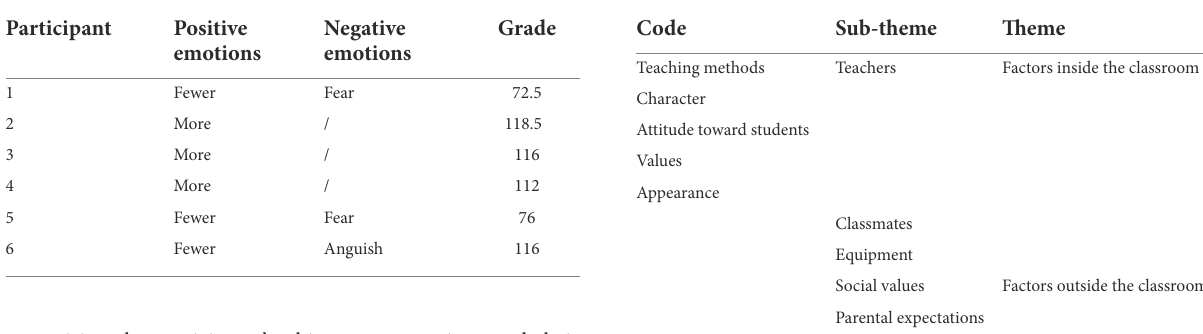
TABLE 4 Participants’ achievement emotions and English grades. TABLE 5 Other antecedents of achievement